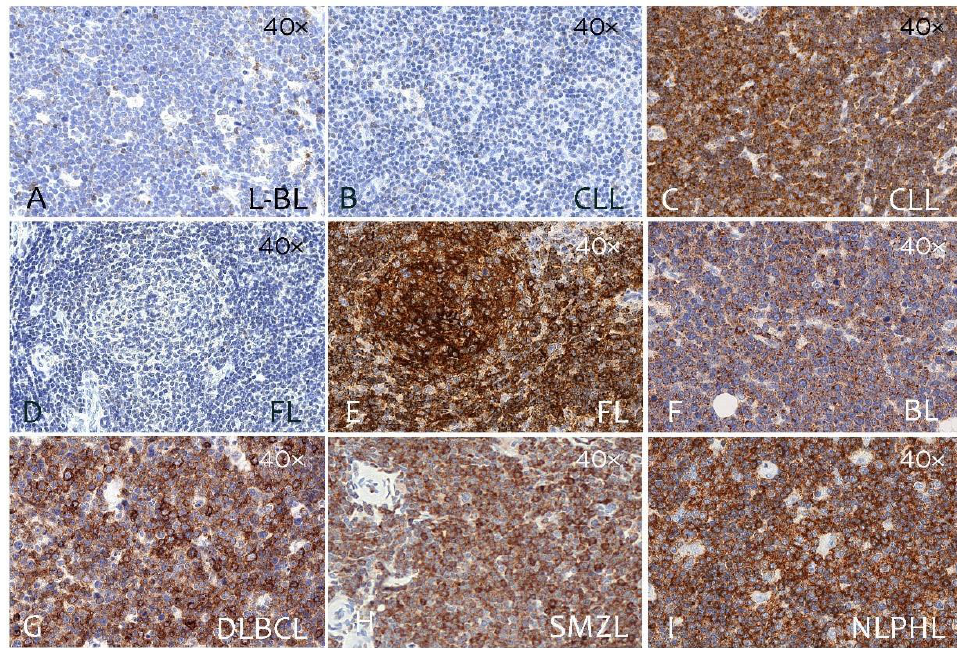
Figure 5 Figure 4. CD229 expression in B-cell lymphomas. Single immunoperoxidase labeling in B-cell lymphomas with mAb (clone PIZCU426) against CD229. Representative examples of B-cell lym- phomas ( A ) B-lymphoblastic lymphoma (L-LB), ( B ) negative case, chronic lymphocytic leukemia (CLL) and ( C ) positive case, CLL, ( D ) negative case, follicular lymphoma (FL) and ( E ) positive case, FL, ( F ) Burkitt lymphoma (BL), ( G ) diffuse large B-cell lymphoma (DLBCL), ( H ) splenic marginal- zone lymphoma (SMZL), and ( I ) nodular lymphocyte-predominant Hodgkin lymphoma (NLPHL). All the pictures are at 40 ×